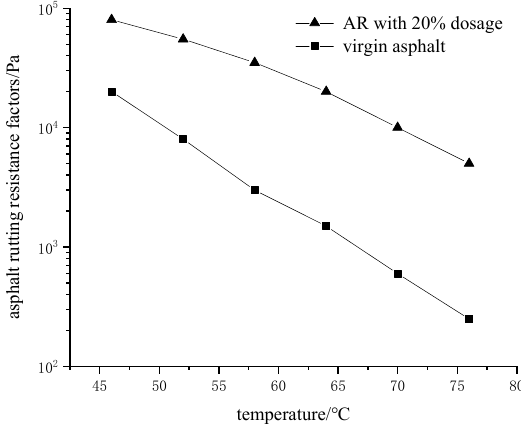
Figure 9. Rutting resistance factors of virgin asphalt and asphalt rubber at different temperatures.